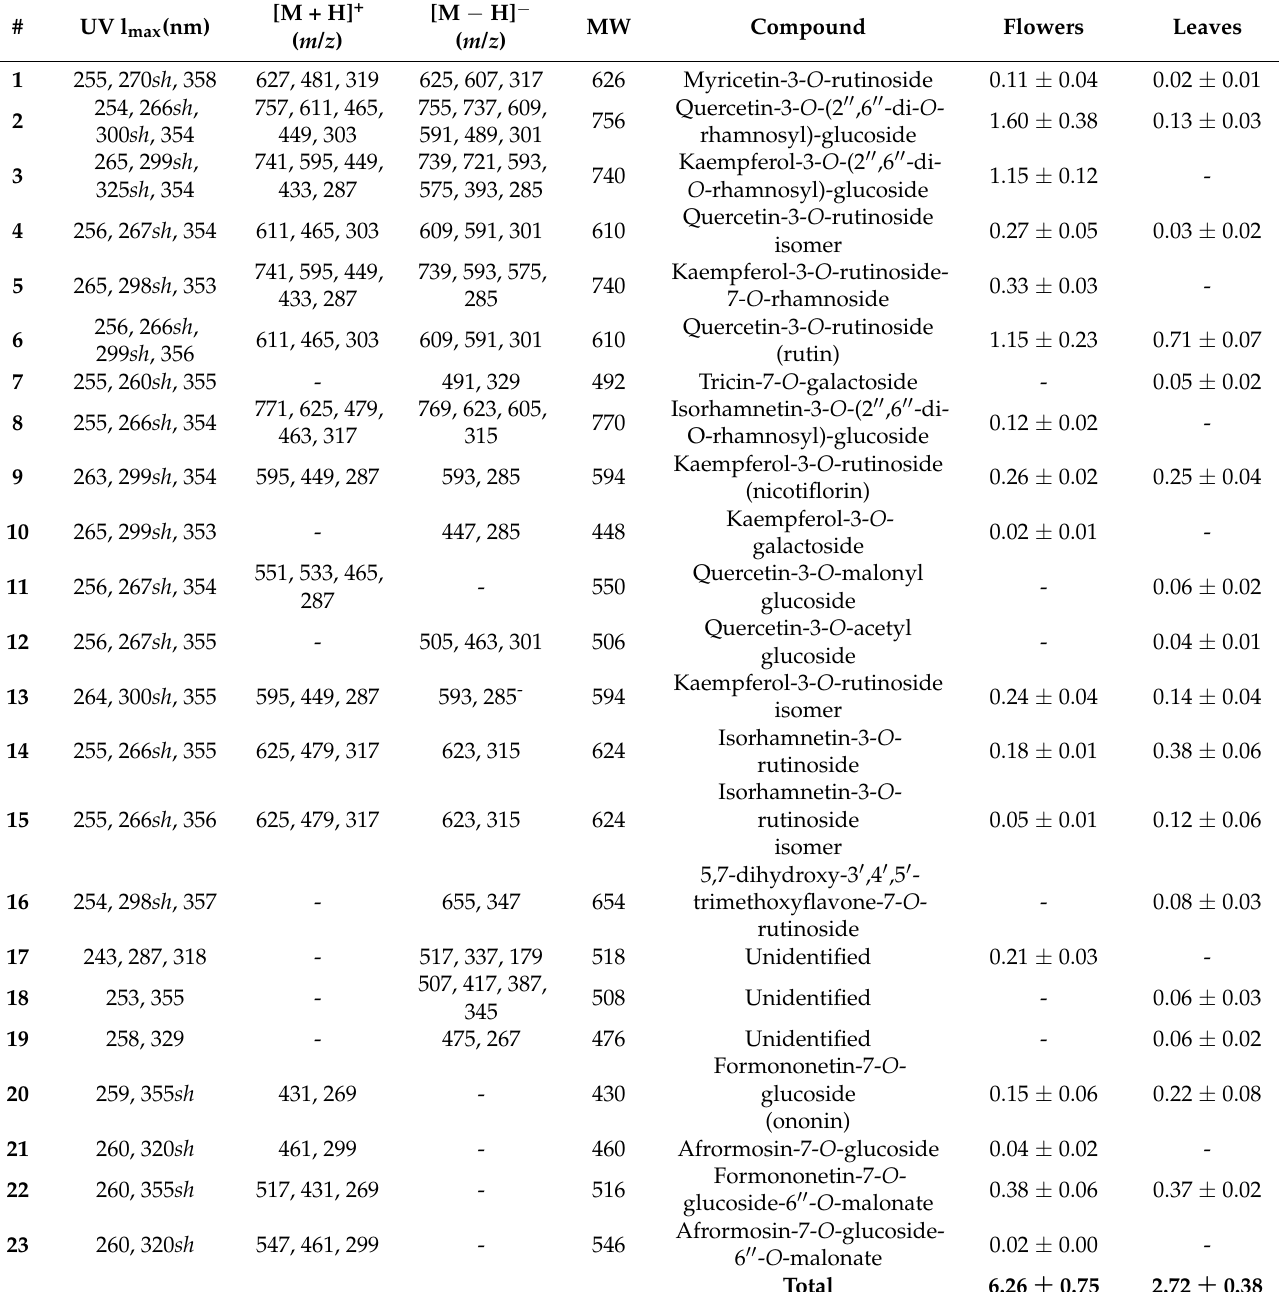
Table 1. Main identified flavonoids and their content (mg/g DM) in flowers and leaves of H. coronarium